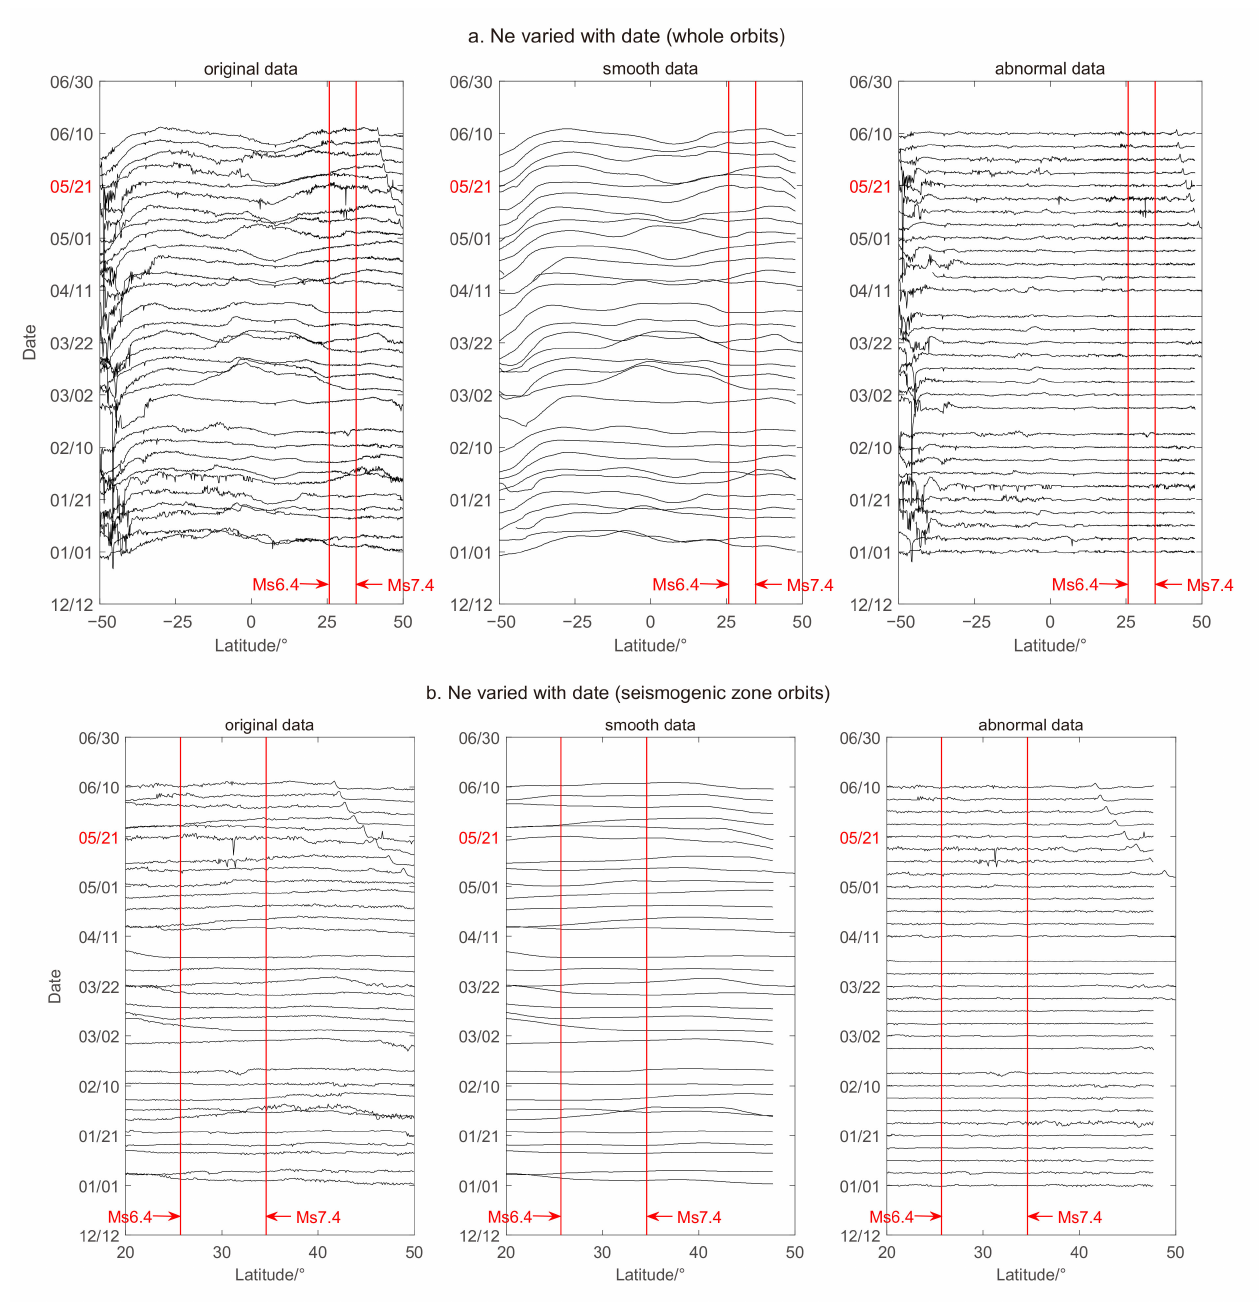
Figure 3. Ne varied with data from 1 January 2021 to 14 June 2021 ( a ). Whole orbits; this range is from 50 ◦ S to 50 ◦ N. ( b ). Seismogenic zone orbits; the seismogenic zone is 21 ◦ N to 49 ◦ N, and we actually use 20 ◦ N to 50 ◦ N. In each figure, the first subfigure represents the original data, the second represents the smooth data, and the third represents the abnormal data. Red lines indicate the latitude of the earthquakes. We take the date of the first earthquake (Yangbi earthquake, 21 May) as the date of these two earthquakes (in